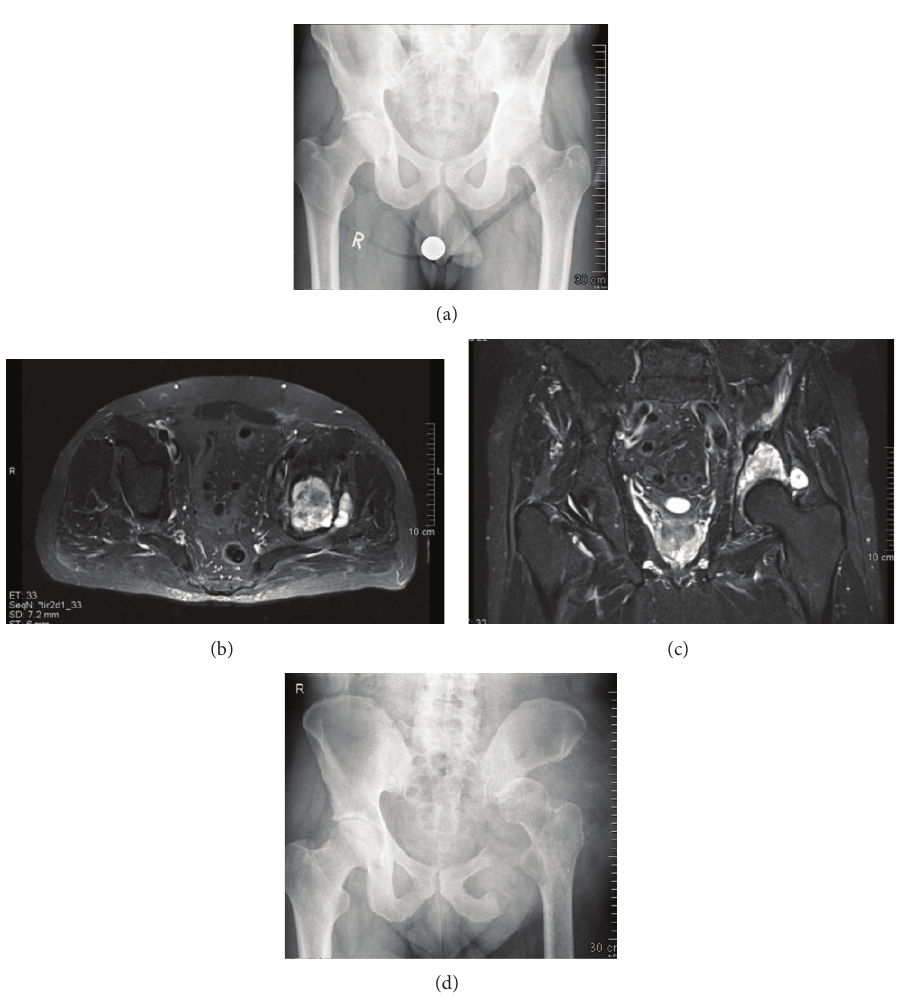
Figure 3: (a) Anteroposterior radiograph of the pelvis, showing a periacetabular chondrosarcoma on the left. (b) and (c) MRI of the pelvis, showing the destruction of the cortical bone and extraosseous tumor expansion. Notably is that the hip joint is not infiltrated. (d) Anteroposterior radiograph after P2 resection and hip